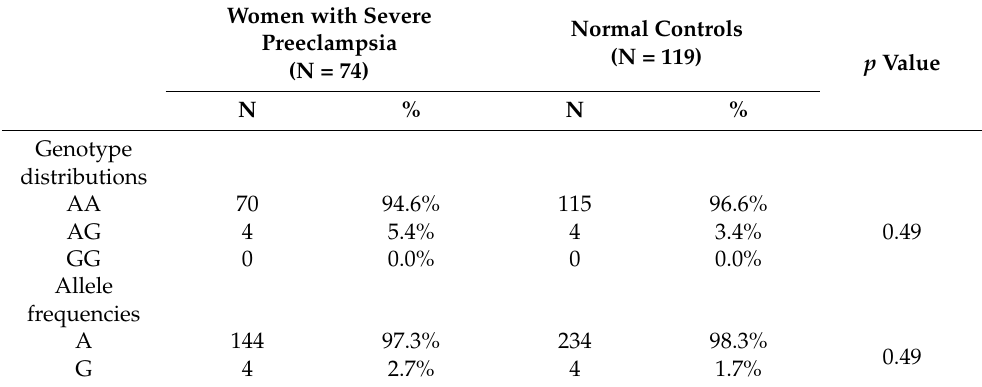
Table 2. Genotype distributions and allele frequencies of the Nla IV polymorphism at the position -238 in the promoter region of the TNF- α gene among women with severe preeclampsia and normal controls.